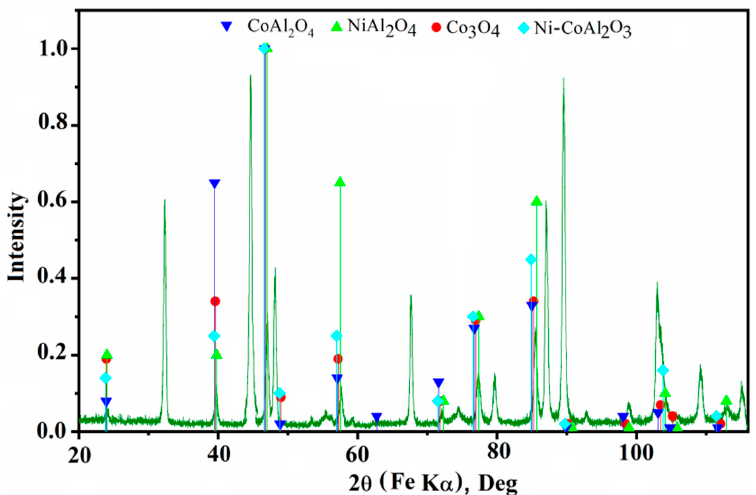
Figure 6. XRD patterns of the obtained catalysts.